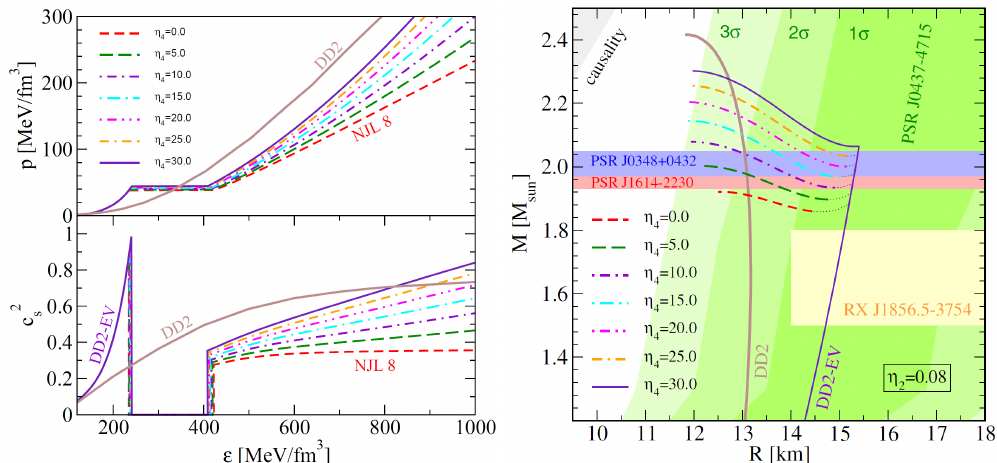
Figure 3. ( Left ) Equation of state (EoS) and speed of sound as a function of the energy density; and ( Right ) M–R relation for the corresponding EoS. Different curves correspond to a variation of the high density quark EoS in terms of a NJL 8-vector coupling parameter η 4 . Figure from